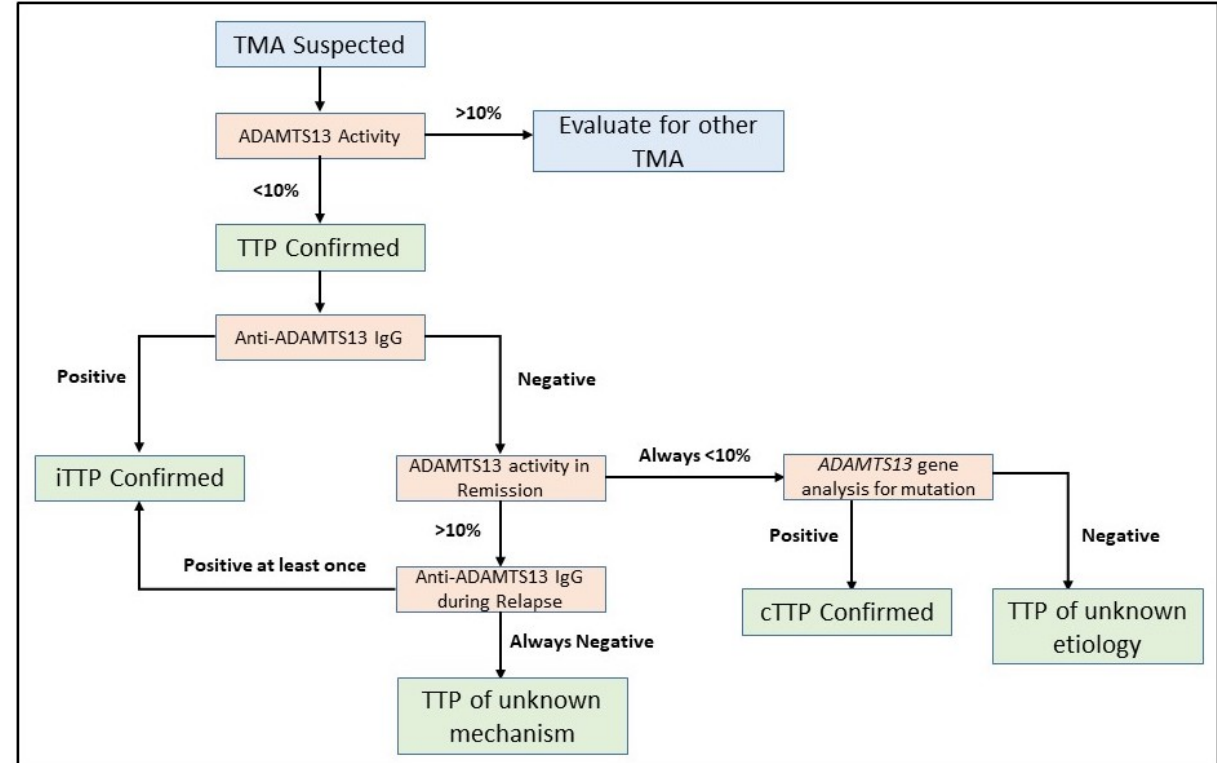
Figure 2. Flowchart for ADAMTS13 investigation in TTP. Severely deficient ADAMTS13 activity of <10% is required to establish a diagnosis of TTP. Further investigation of anti-ADAMTS13 IgG inhibitory autoantibodies are required to document the mechanism of ADAMTS13 deficiency. ADAMTS13 gene analysis for biallelic mutations is reserved for selected situations to confirm a diagnosis of cTTP. In some cases, the underlying mechanism of ADAMTS13 activity deficiency is not immediately clear and repeated measurements of ADAMTS13 activity in remission and anti-ADAMTS13 IgG during relapse events can help establish a diagnosis.